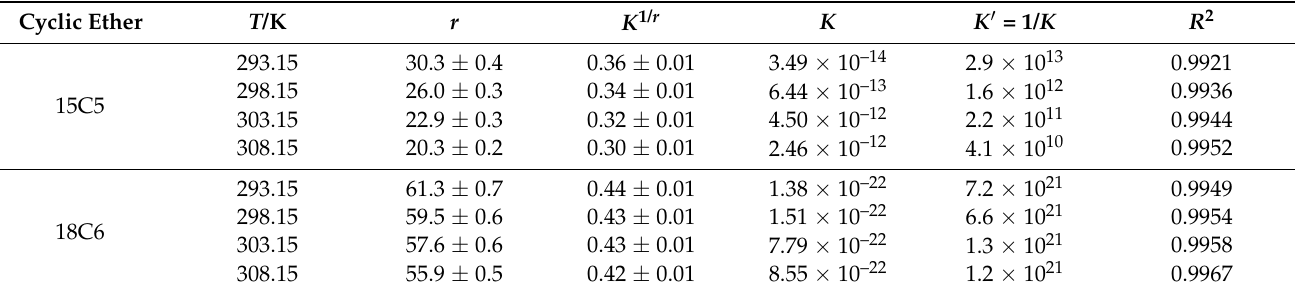
Table 2. Parameters of Equation (8) for the preferential solvation of cyclic ethers in the F + W mixtures. Cyclic Ether T/